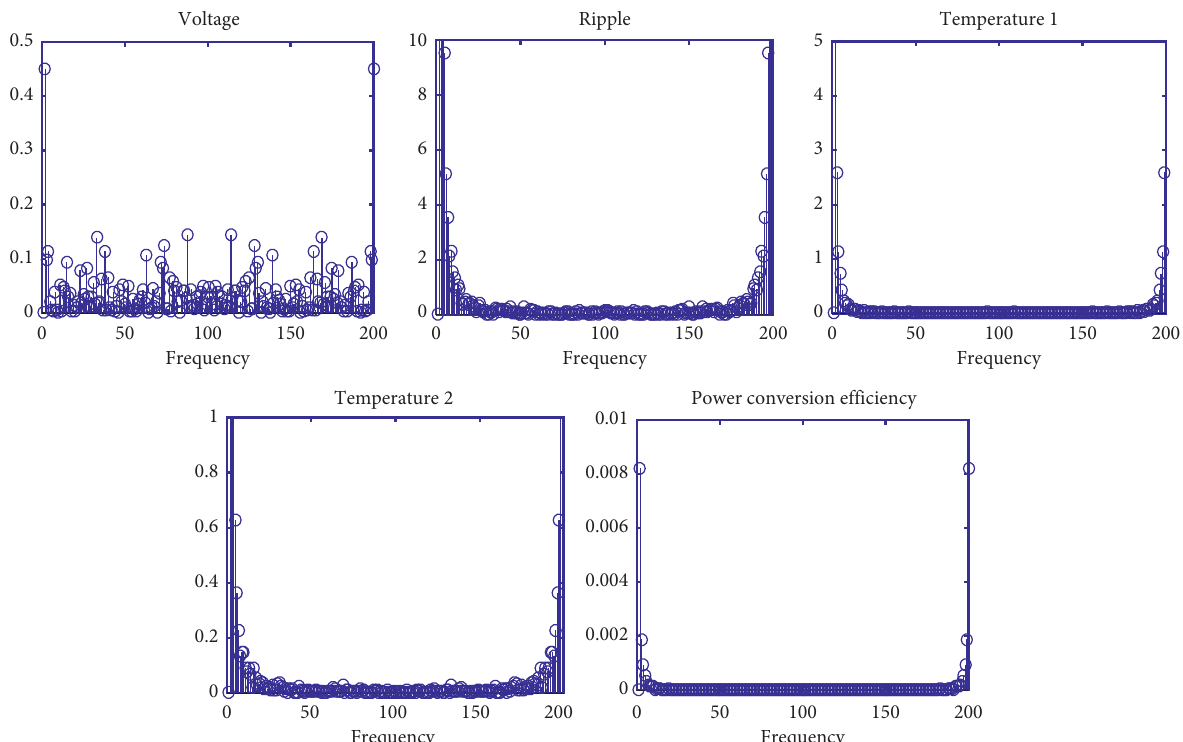
Figure 11: Power spectrum of power source key characteristic parameters based on fast Fourier